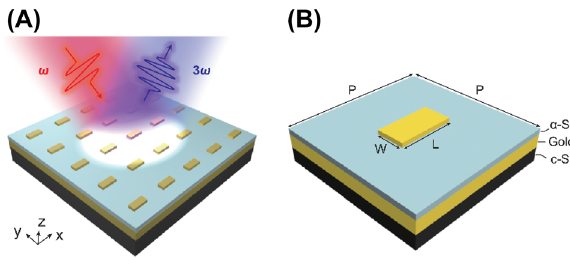
Figure1: SchematicillustrationoftheTHGfromthegold/ α -Sihybrid